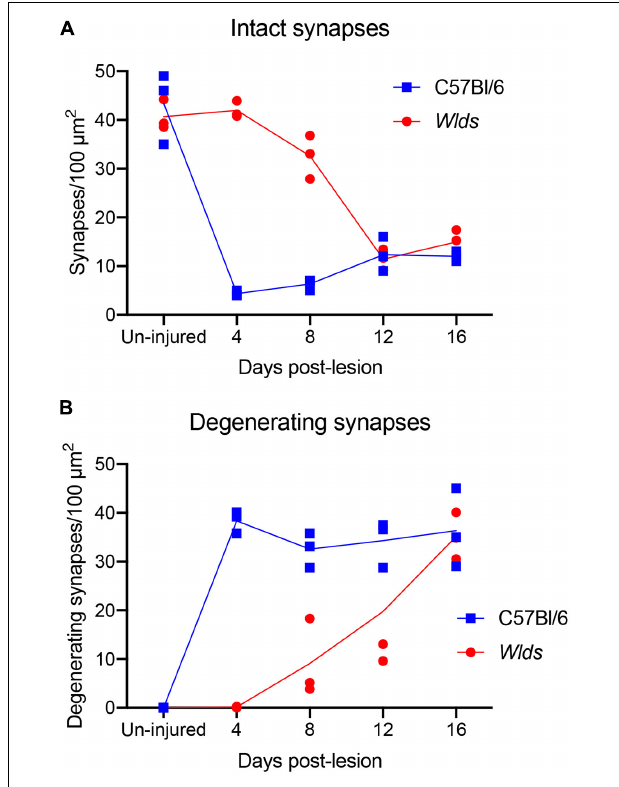
FIGURE 3 | Counts of intact synapses (A) and degenerating synapses (B) per 100 µ m 2 of neuropil in un-injured C57Bl/6 vs. Wld s mice at different times post-injury.